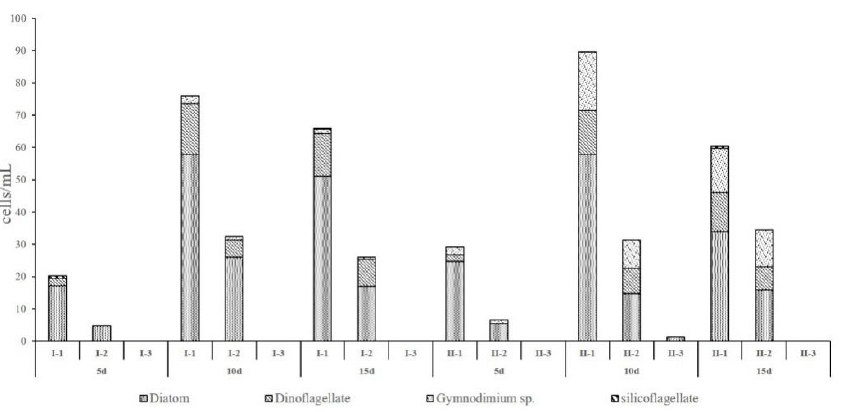
Figure 9. Effect of different algal inhibition method on microcapsule germination in sediment (I) and In situ sediment added with G. catenatum cyst (II) .